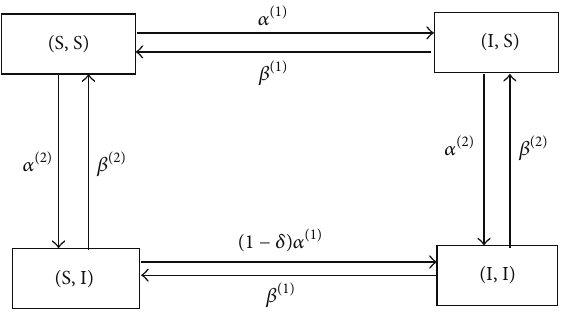
Figure 1: State transition diagram of the immune